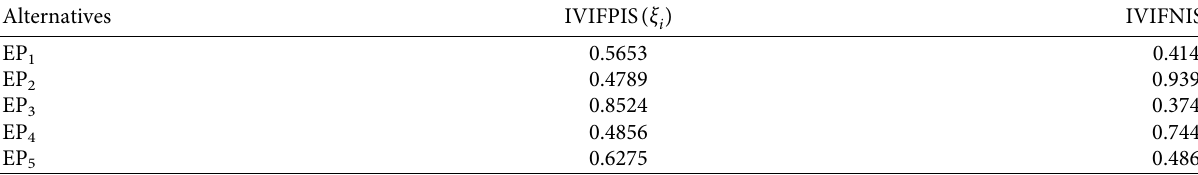
) and IVIFNIS ( ξ i